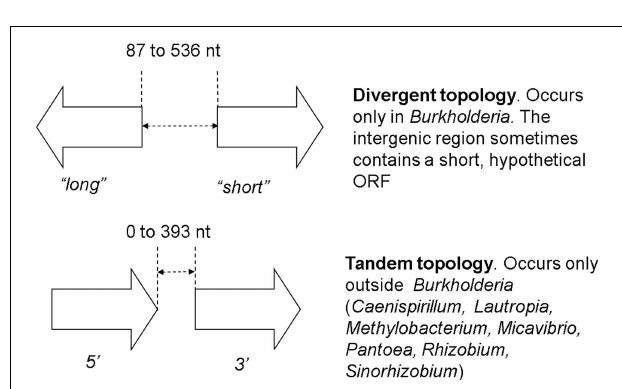
FIGURE 3 | Twin luxR arrangements and the suggested notation. The genes occurring in these topologies are listed in Supplementary Materials Table 2. It is important to note that the two arrangements are taxonomically distinct, i.e., one taxon contains either one or the other.